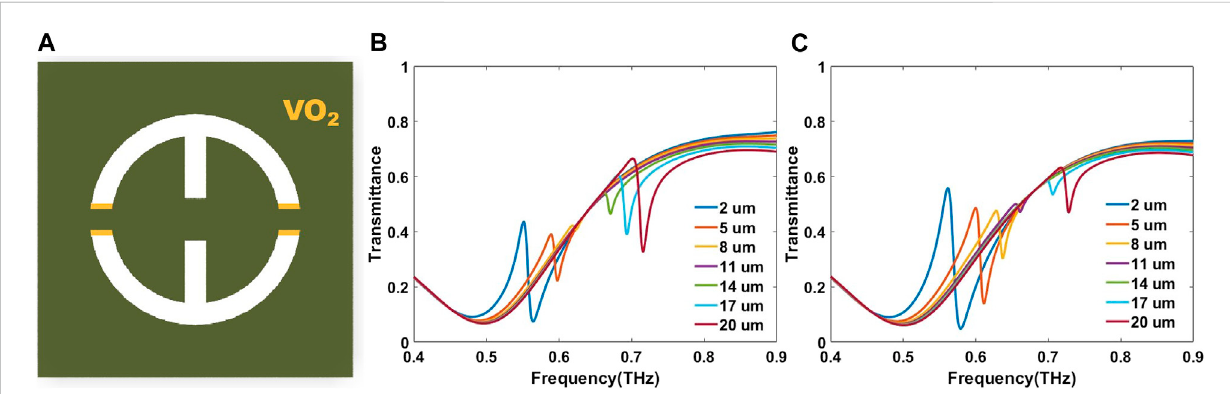
FIGURE 2 (A) Schematic diagram of the Al − VO 2 metasurface. The metal design dimensions are as follows: period p = 100 µm, the ring outer diameter D = 120 µm, width W = 10 µm, double seam width g 1 = 15 µm, control the change of g 2 . Vanadium oxide fi lling both sides seam width to 10 µm. (B) The low- temperature regime and the amplitude transmission spectrum of the metasurfaces of different g 2 . (C) High-temperature state, the amplitude transmission spectrum of the metasurfaces of different g 2 .